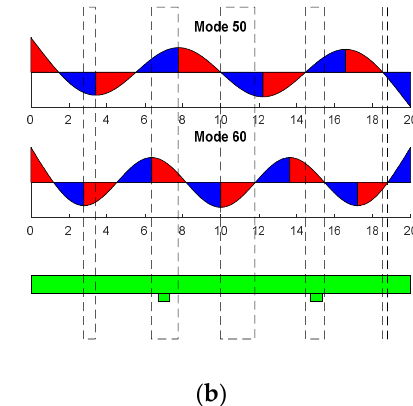
Table 2. Summary of the parameters to consider for the operation mode of the TW- and the SW-based